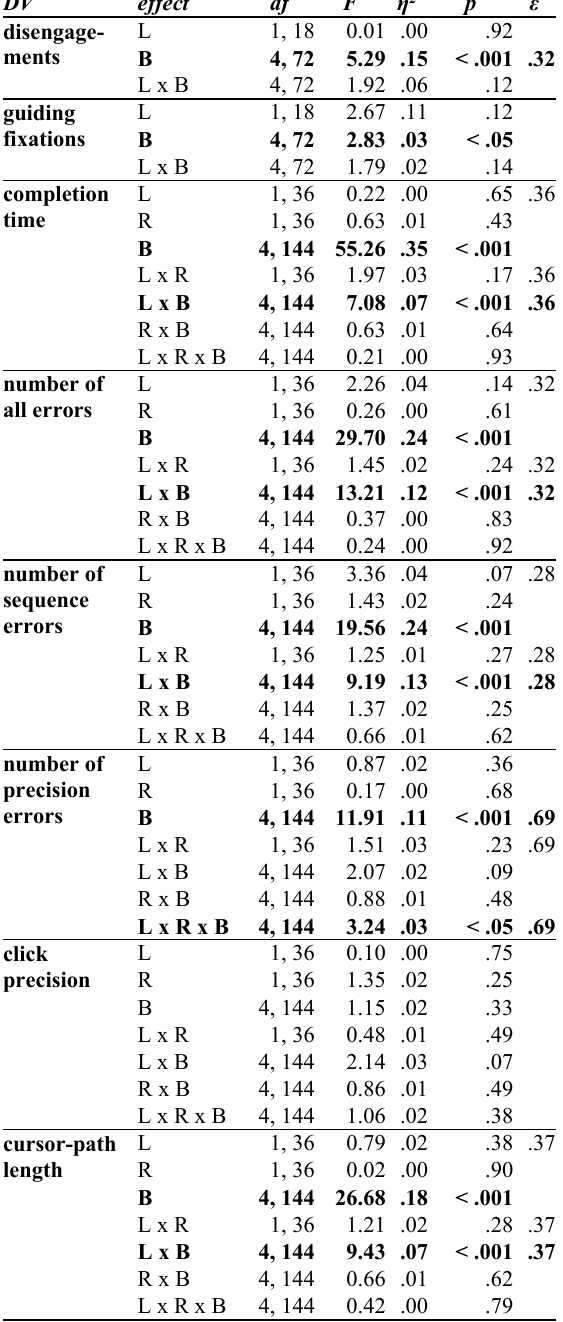
Table 4. ANOVA results of the recall phase of Experiment